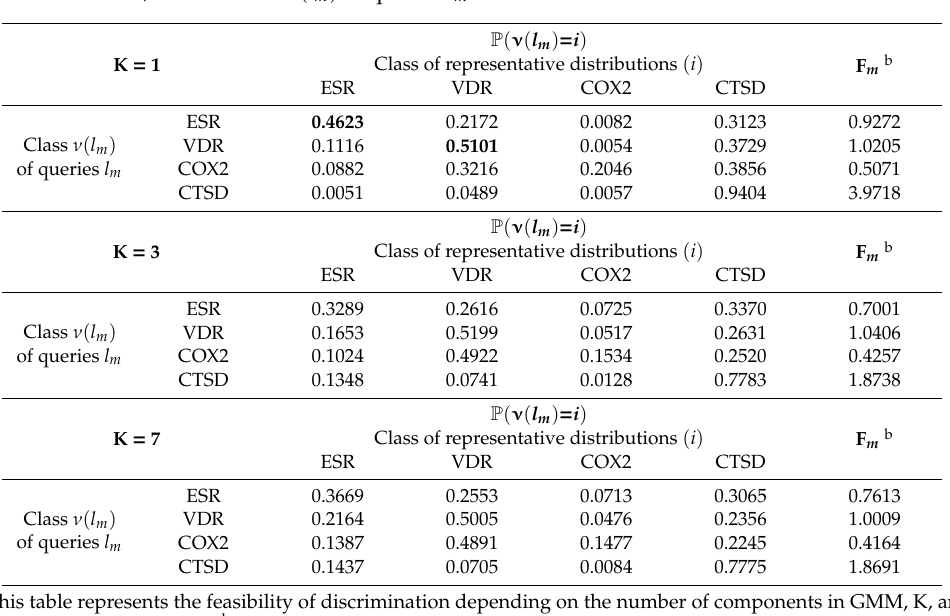
Table 4. The description on P ( ν ( l m ) = i ) and F m according to the number of components of Gaussian Mixture Model K, and the class ν ( l m ) of queries l m a .